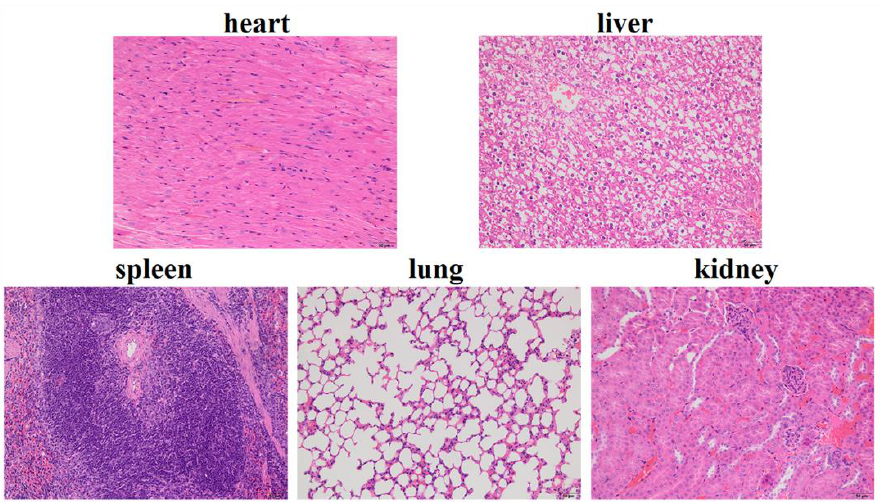
Figure 8. Images of H&E-stained major organ tissue sections of SF-AGN.